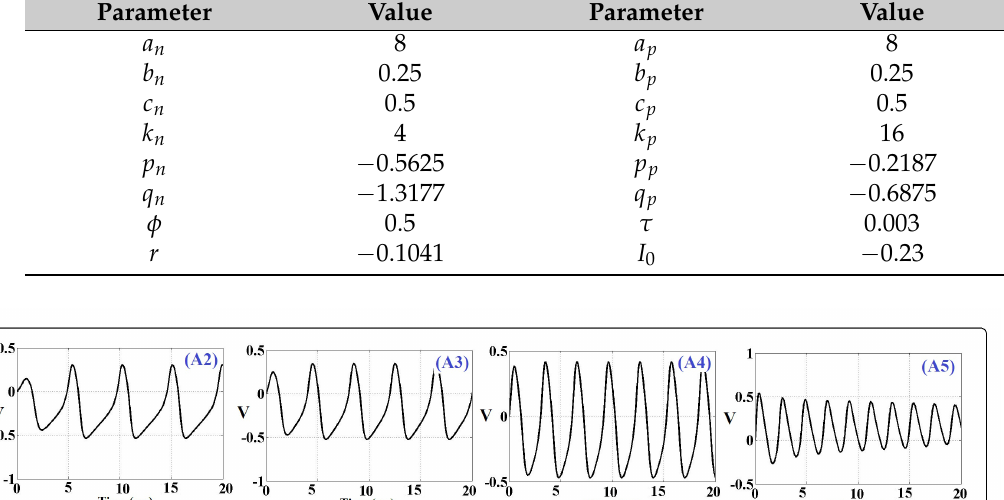
Table 2. Different Parameters for Reproducing the Class II Pattern.